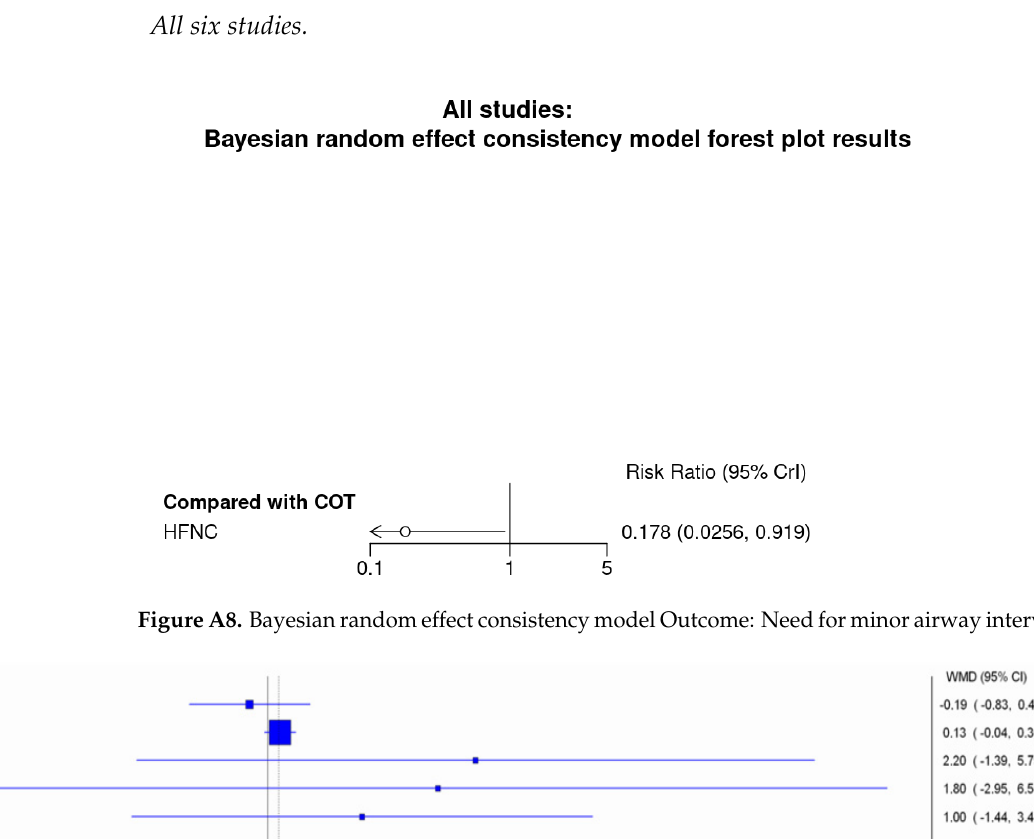
Figure A7. Trial sequential analysis: incidence of hypercapnia. All six studies.